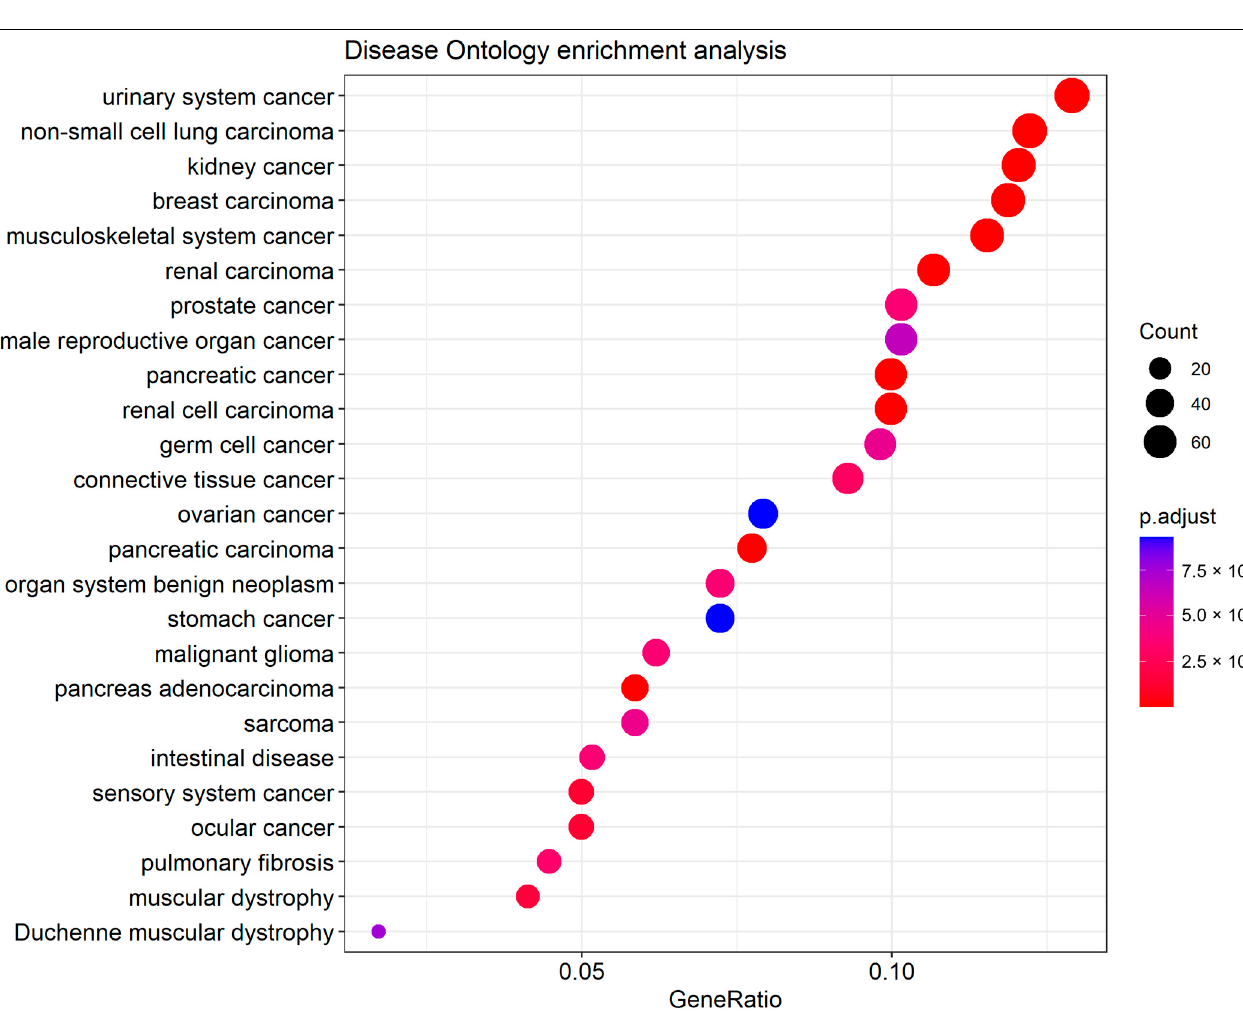
Figure 7. Top 25 significant terms of the Disease Ontology (DO) enrichment